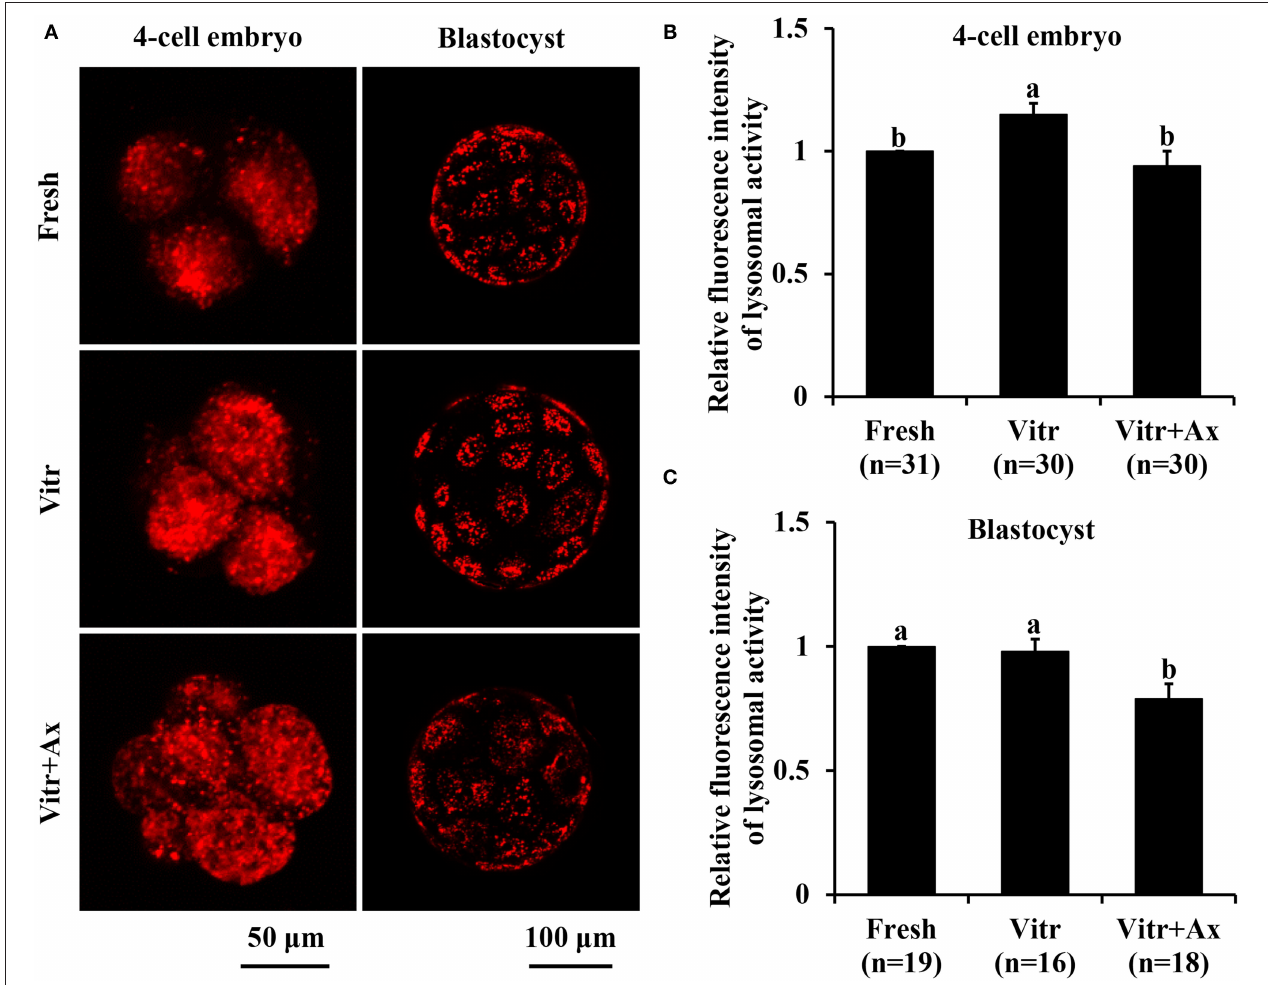
FIGURE 6 | Effects of astaxanthin (Ax) supplementation on intracellular lysosomal activity in resultant 4-cell embryos and blastocysts. (A) Representative images of lysosomal signals stained with LysoTracker TM Red. (B,C) Graphical representation of lysosomal activity by quantifying the relative fluorescence intensity. Four replications were performed. Data are the mean ± SEM values. Different superscripts above columns indicate significant differences ( P < 0.05). The three experimental groups: fresh zygotes (Fresh group), vitrified zygotes (Vitr group), and vitrified zygotes cultured with Ax (Vitr + Ax